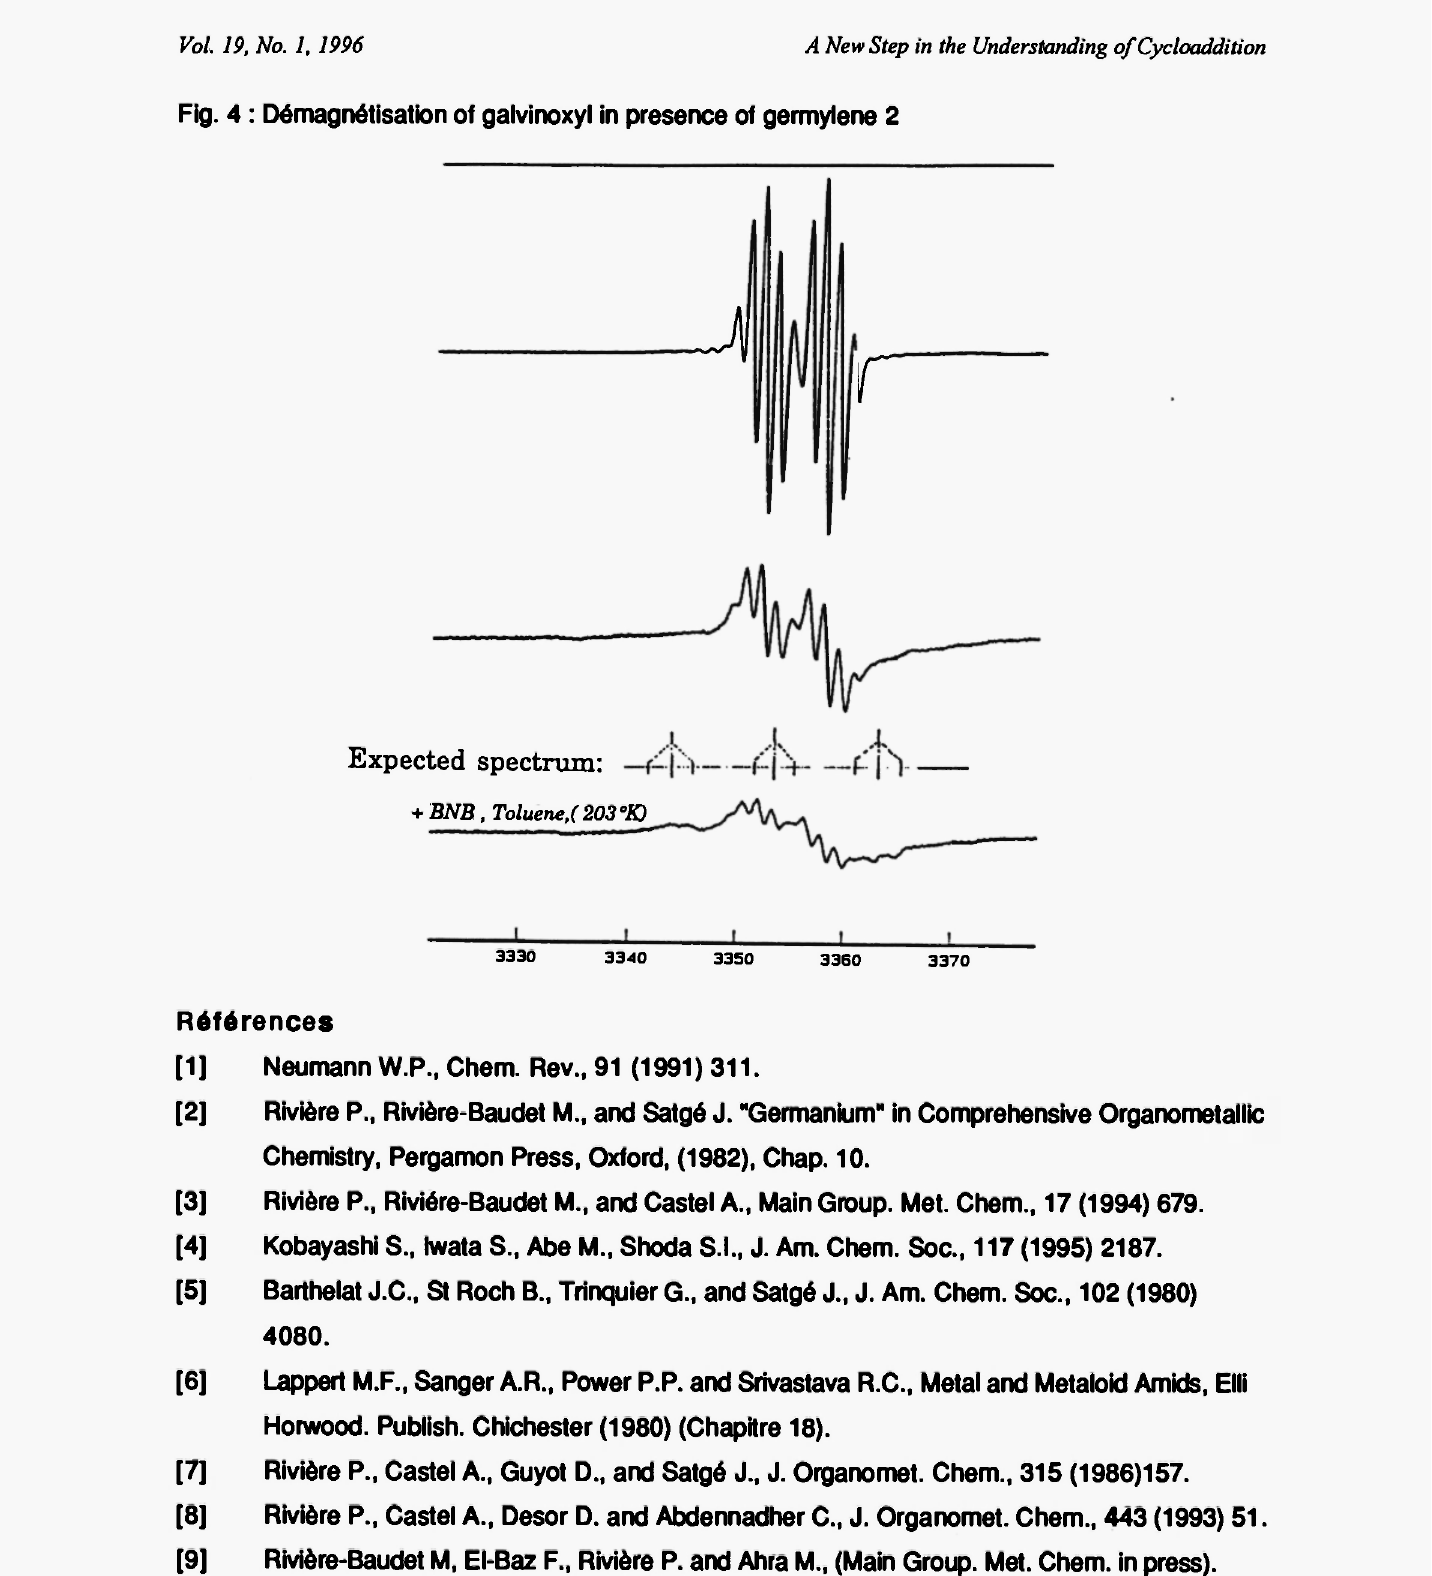
Fig. 4 : Demagnetisation of galvinoxyl in presence of germylene 2